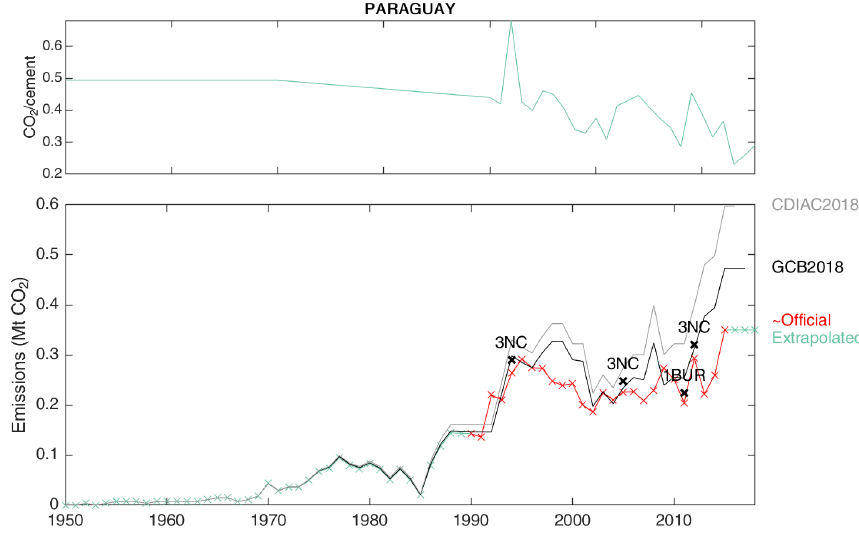
Figure C35. Revised cement emissions for Paraguay.